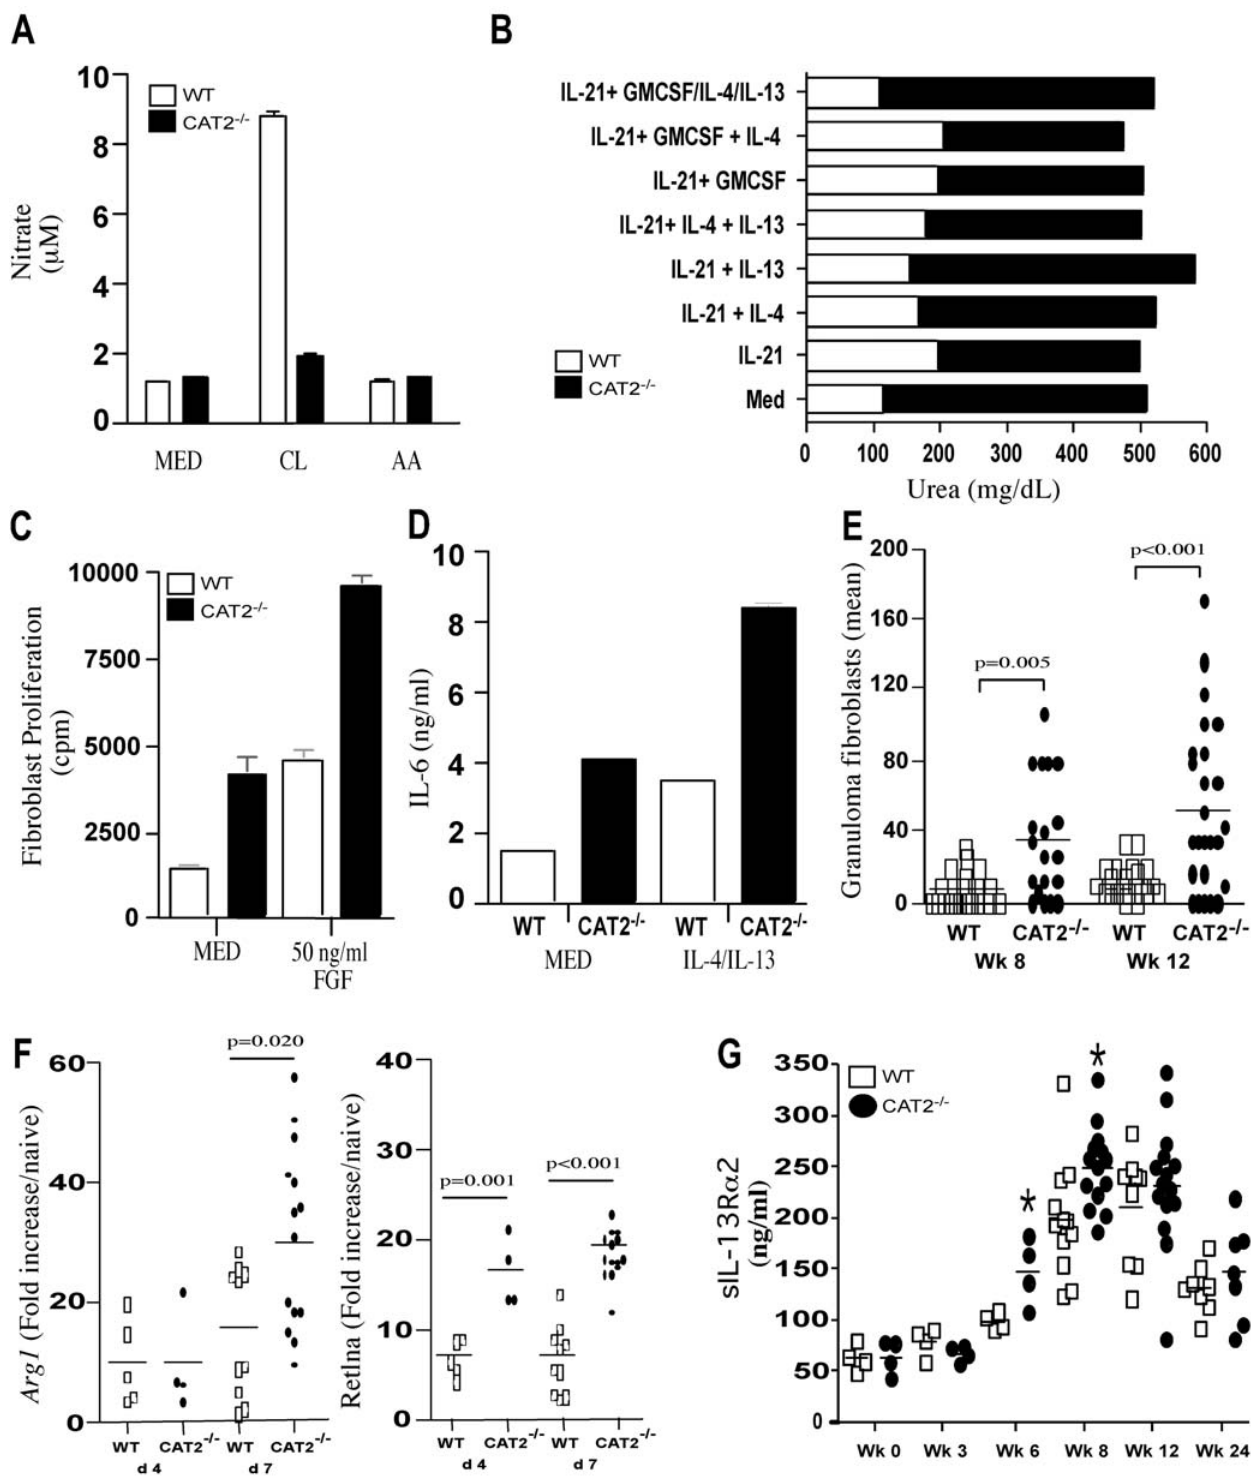
Figure 8. CAT2 2 / 2 primary fibroblasts display increased proliferative responses and spontaneous arginase activity. A. WT C57BL/6 (open bars) and CAT2 2 / 2 (filled bars) primary lung fibroblasts were stimulated with medium alone, IFN- c /LPS (100 U/ml/100 ng/ml, CL), or with IL-4/ IL-13 (20 ng/ml, AA). After 24 hr, NO activity was quantified by measuring nitrate levels in the supernatants. B. WT and CAT2 2 / 2 fibroblasts were plated at 5 6 10 5 cells per well and stimulated with various type-2 cytokines that promote alternative activation. Arginase activity was quantified by measuring urea production (mg/dL). C. WT and CAT2 2 / 2 fibroblasts were plated at 1 6 10 5 cells/well, stimulated with medium alone or 50 ng/ml FGFb, and proliferation was measured by (H 3 ) thymidine incorporation. D. WT and CAT2 2 / 2 fibroblasts were plated at 1 6 10 5 cells/well and cultured in the presence of medium alone or IL-4/IL-13 (20 ng/ml). After 24 hr incubation, the supernatants were assayed for IL-6. All assays were repeated with similar results. E. Fibroblasts in granulomas at 8 and 12 wk post-infection with S. mansoni (% adjusted proportionally by granuloma size). Spots